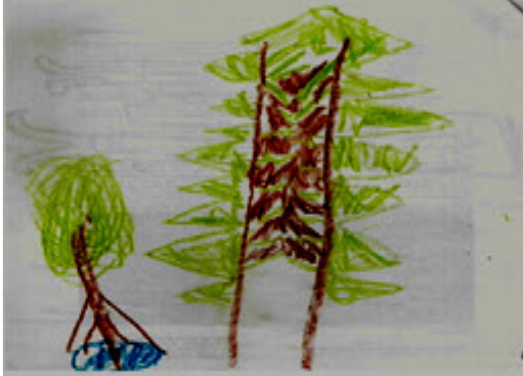
Picture 3. Image of child of 9 years, with lim - ited social contacts